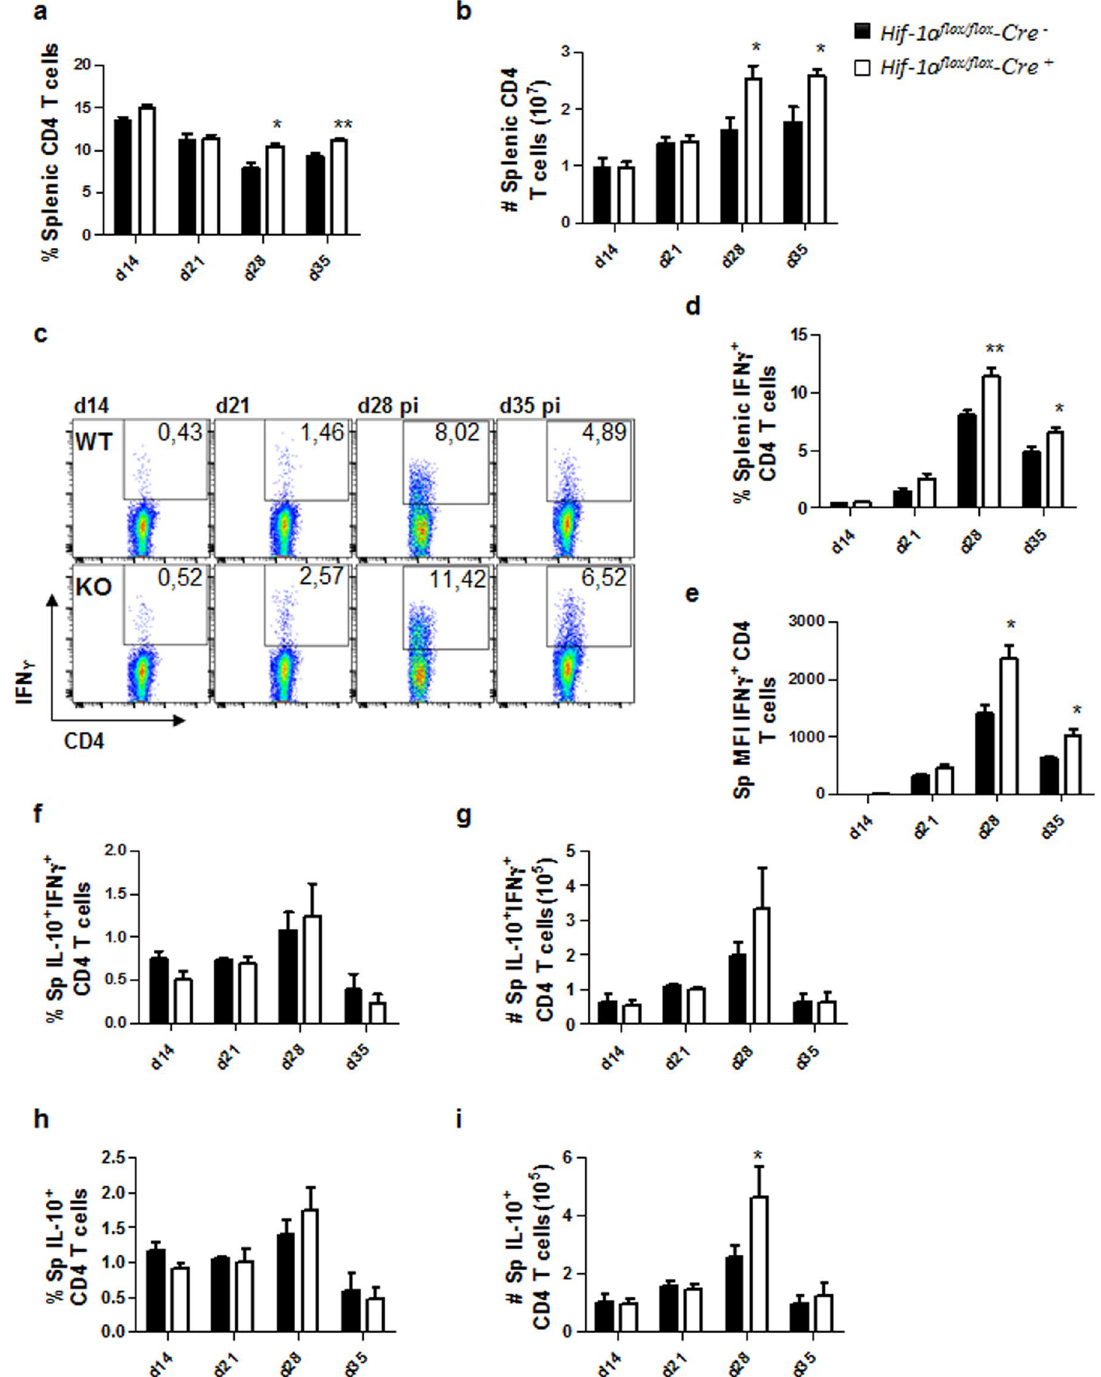
Figure 2. HIF-1 α expression in CD11c + cells limits expansion of Th1 cells during chronic visceral leishmaniasis. Hif-1 α flox/flox Cd11c-Cre − (WT) and Hif-1 α flox/flox Cd11c-Cre + (KO) mice were infected with 2 × 10 7 amastigotes intravenously. ( a ) Graph represents the frequency and ( b ) absolute numbers of splenic CD4 T cells. ( C ) Representative FACS plots for IFN γ + CD4 T cells of Hif-1 α flox/flox Cd11c-Cre − (upper panels) and Hif-1 α flox/ flox Cd11c-Cre + mice (lower panels) in the spleen. ( d ) Percentage and ( e ) mean fluorescence intensity (MFI) of IFN γ + CD4 T cells in the spleen. Frequency ( f ) and numbers ( g ) of IFN γ + IL-10 + double producing CD4 T cells; percentage ( h ) and numbers ( i ) of IL-10 + single producers CD4 T cells in the spleen over the course of infection. All data represent mean ± SEM of one of 3 independent experiments, n =